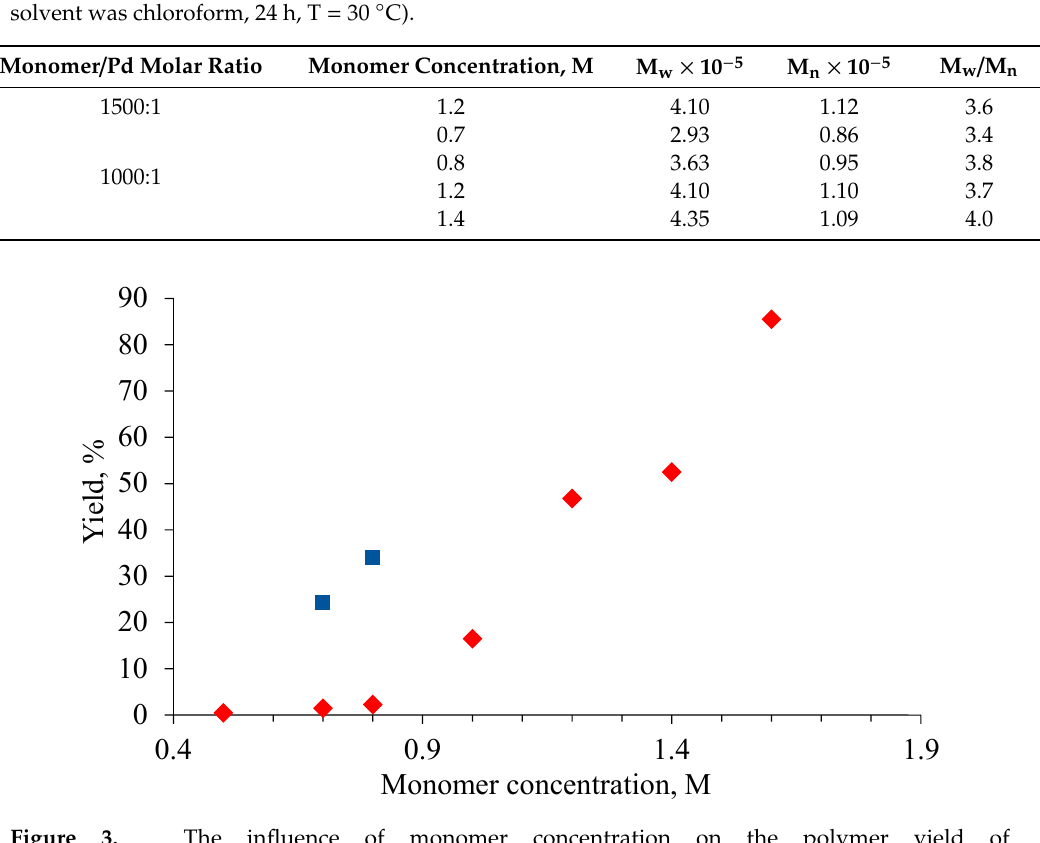
Figure 3. The influence of monomer concentration on the polymer yield of addition poly(3-pentafluorophenyltricyclononene-7) (the catalyst was Pd(OAc) 2 / NaBARF / PCy 3 ; the Pd(OAc) 2 / NaBARF / PCy 3 molar ratio was 1:5:2; the monomer / Pd molar ratio was 1000:1; the solvent was chloroform; the reaction time was 24 h (diamond markers) or 160 h (square markers); T = 30 °C).